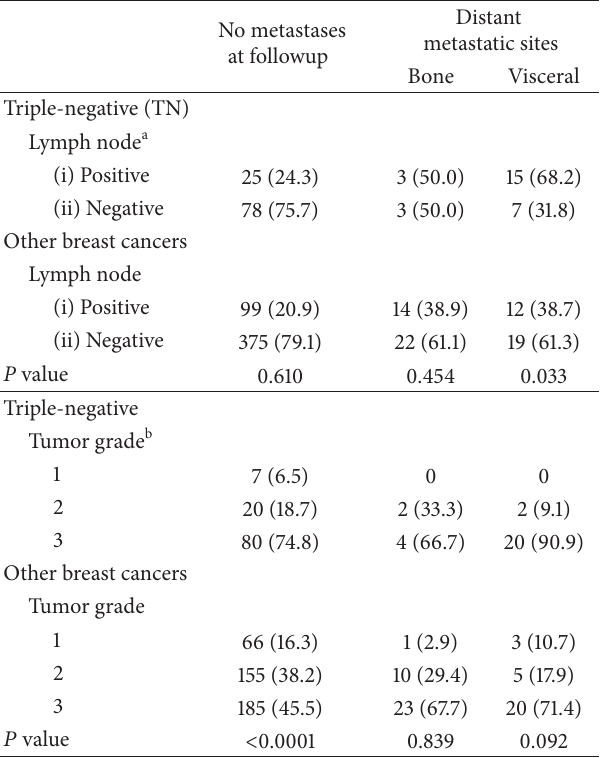
Table 4: Patterns of metastatic spread by lymph node status and